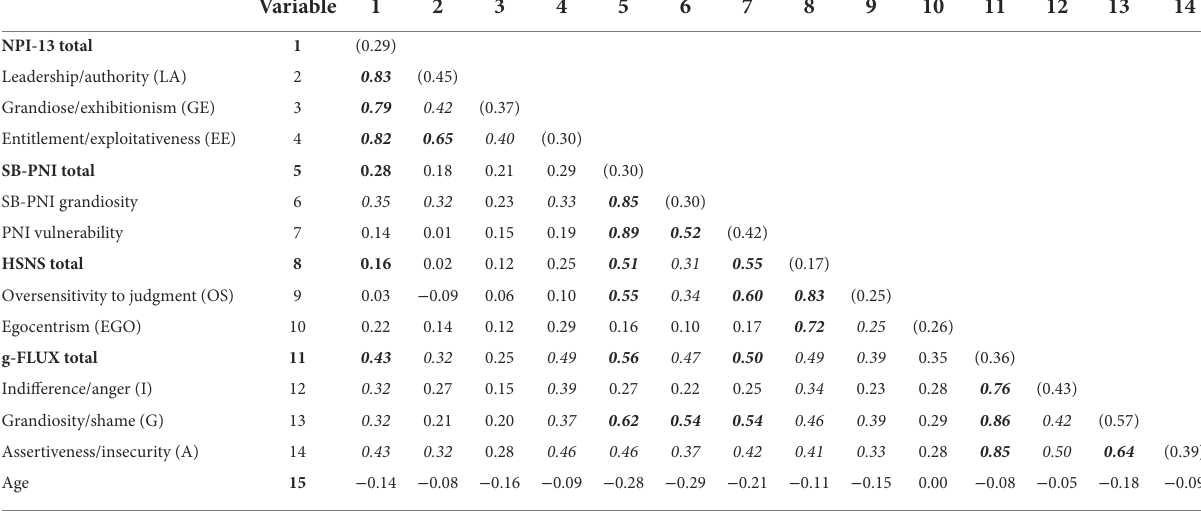
TABLE 4 Intercorrelations between brief narcissism scales, subscales, and